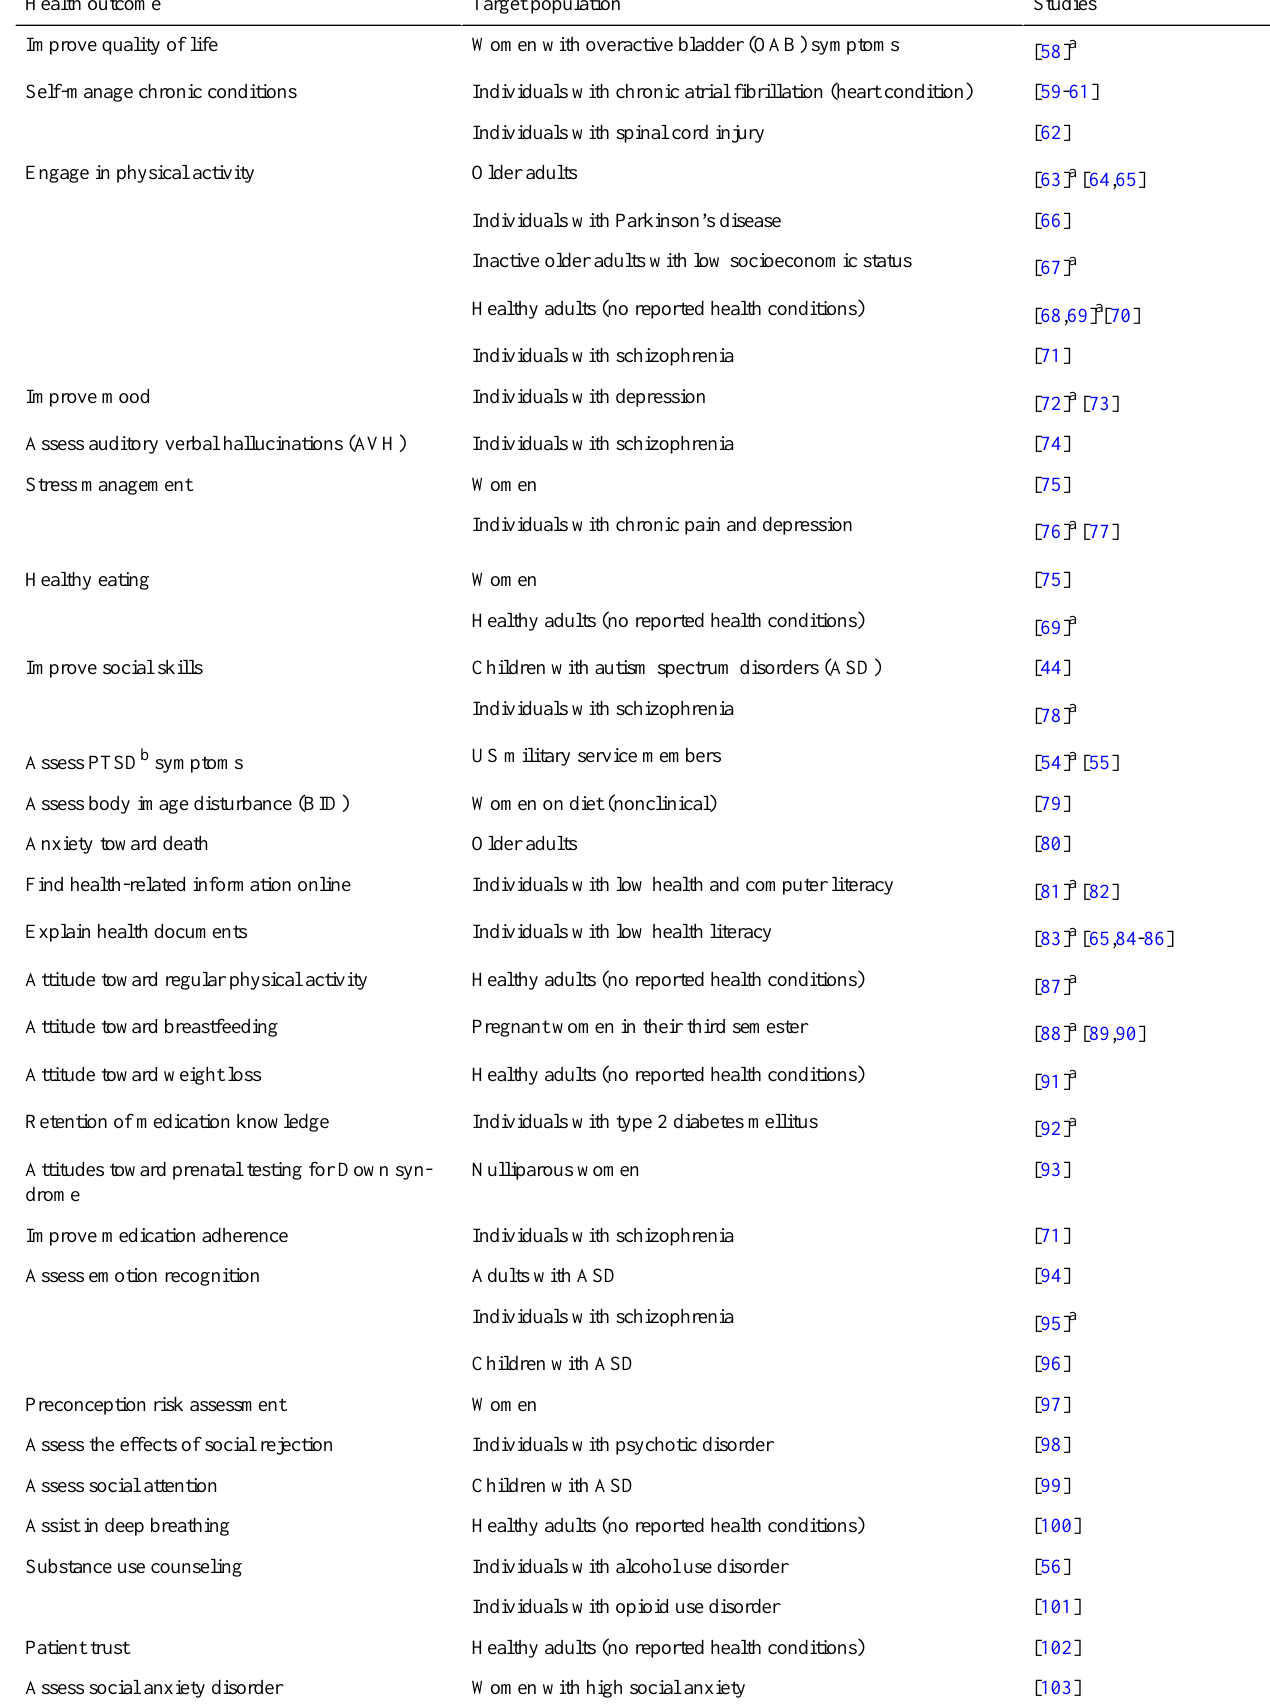
Table 1. In the 53 eligible articles, 30 health-related outcomes and 25 target populations were